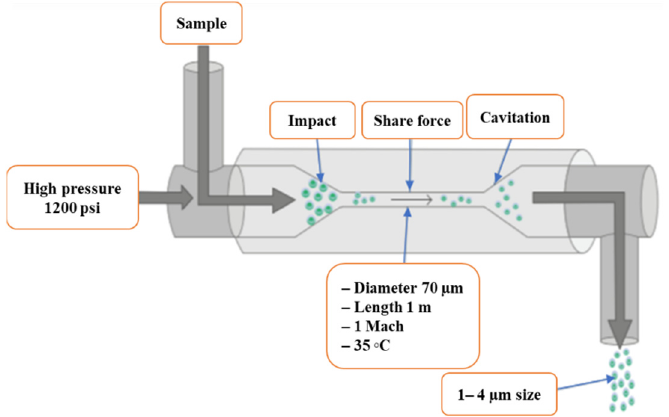
Figure 3. A schematic diagram of a high-pressure homogenizer used for the cell disruption of